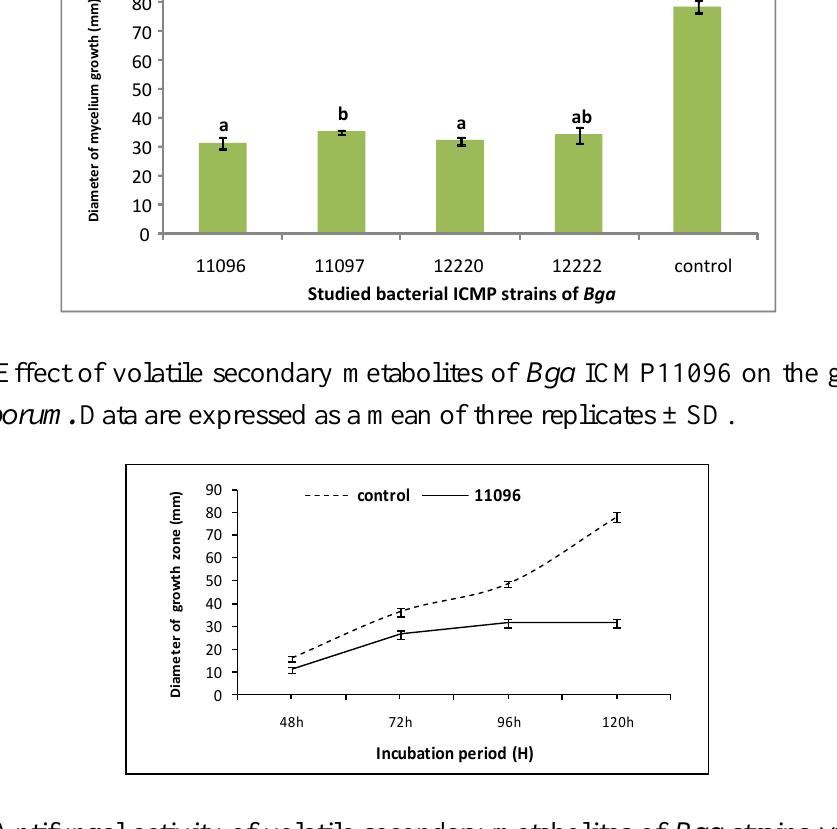
Figure 4. Antifungal activity of volatile secondary metabolites of Bga strains vs. R. solani (five days). Bars with different letters indicate mean values significantly different at p < 0.05 according to Duncan test. Data are expressed as mean of three replicates 